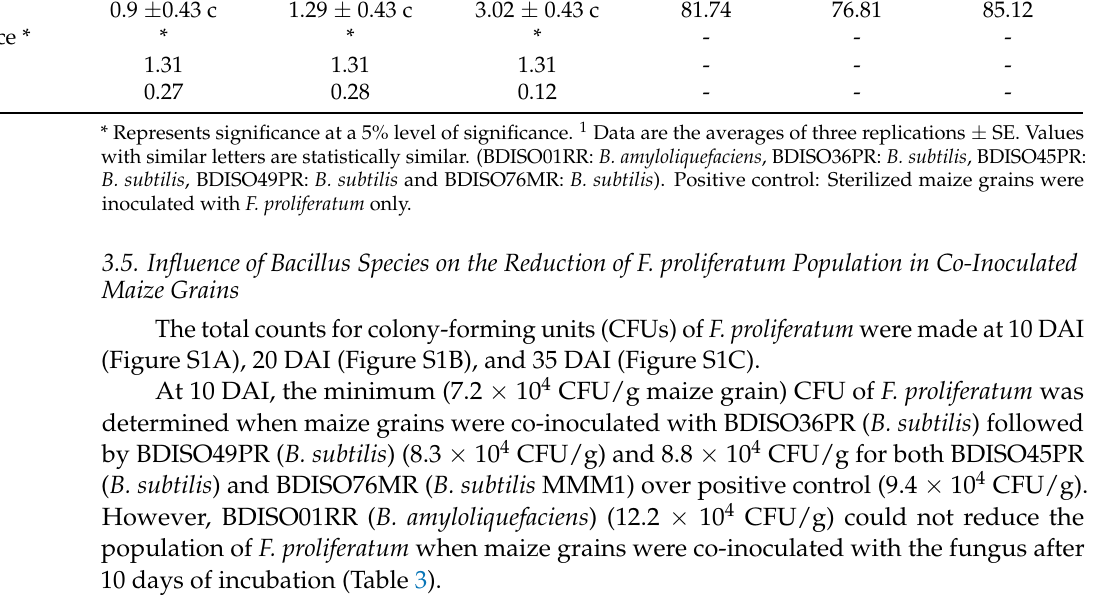
Table 3. Influence of Bacillus species on the reduction of F. proliferatum population in co-inoculated maize